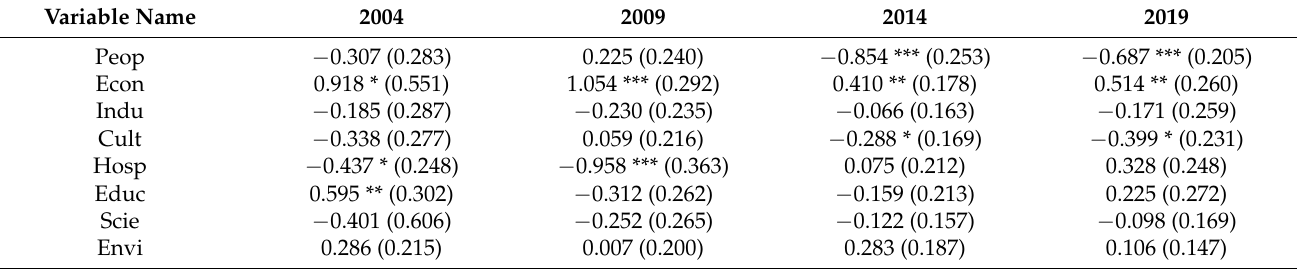
Table 4. Tobit regression results of influencing factors of GLUE on resource-based cities in the